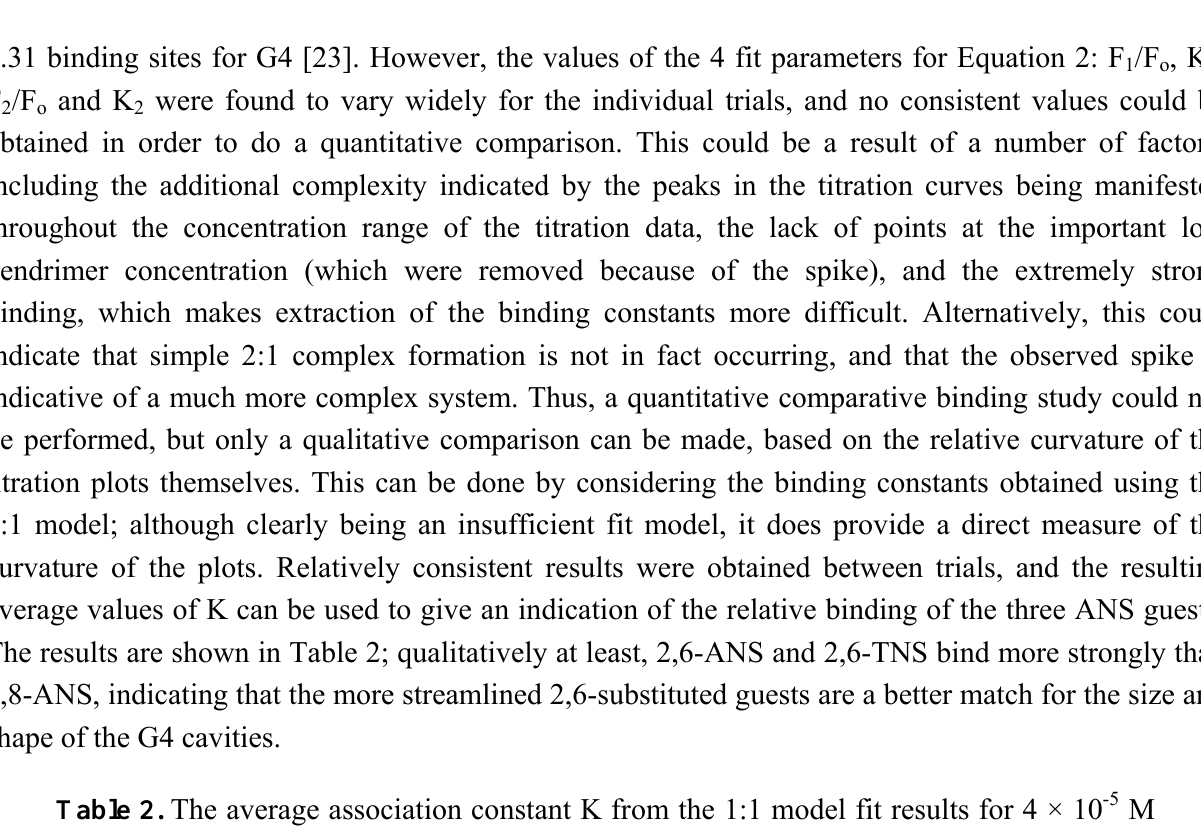
Table 2. The average association constant K from the 1:1 model fit results for 4 × 10 -5